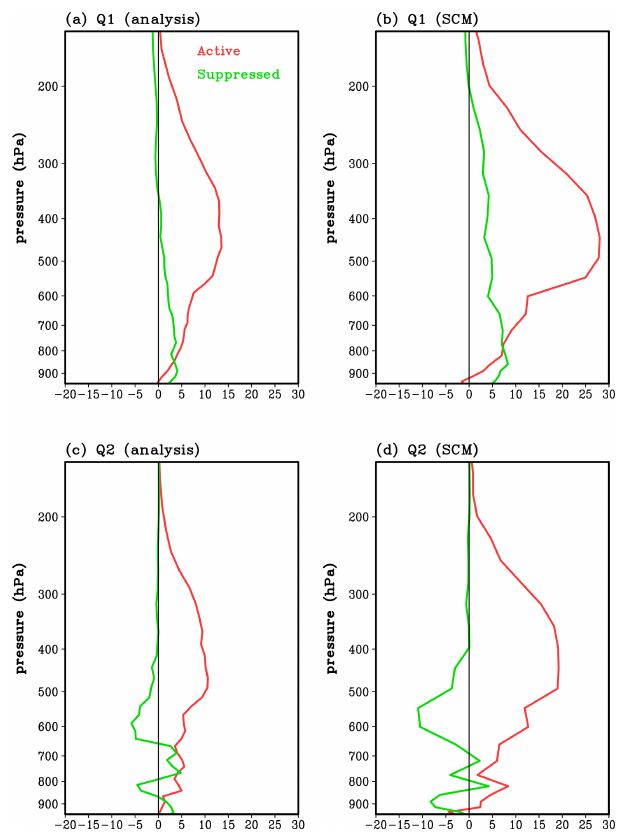
Figure 7. The diabatic heating source (Q1, Kd − 1 ) profiles from (a) sounding analysis, (b) SCM simulation, and diabatic drying sink (Q2, Kd − 1 ) from (c) sounding analysis and (d) SCM simulation. The active monsoon period is in red, and the suppressed period is in